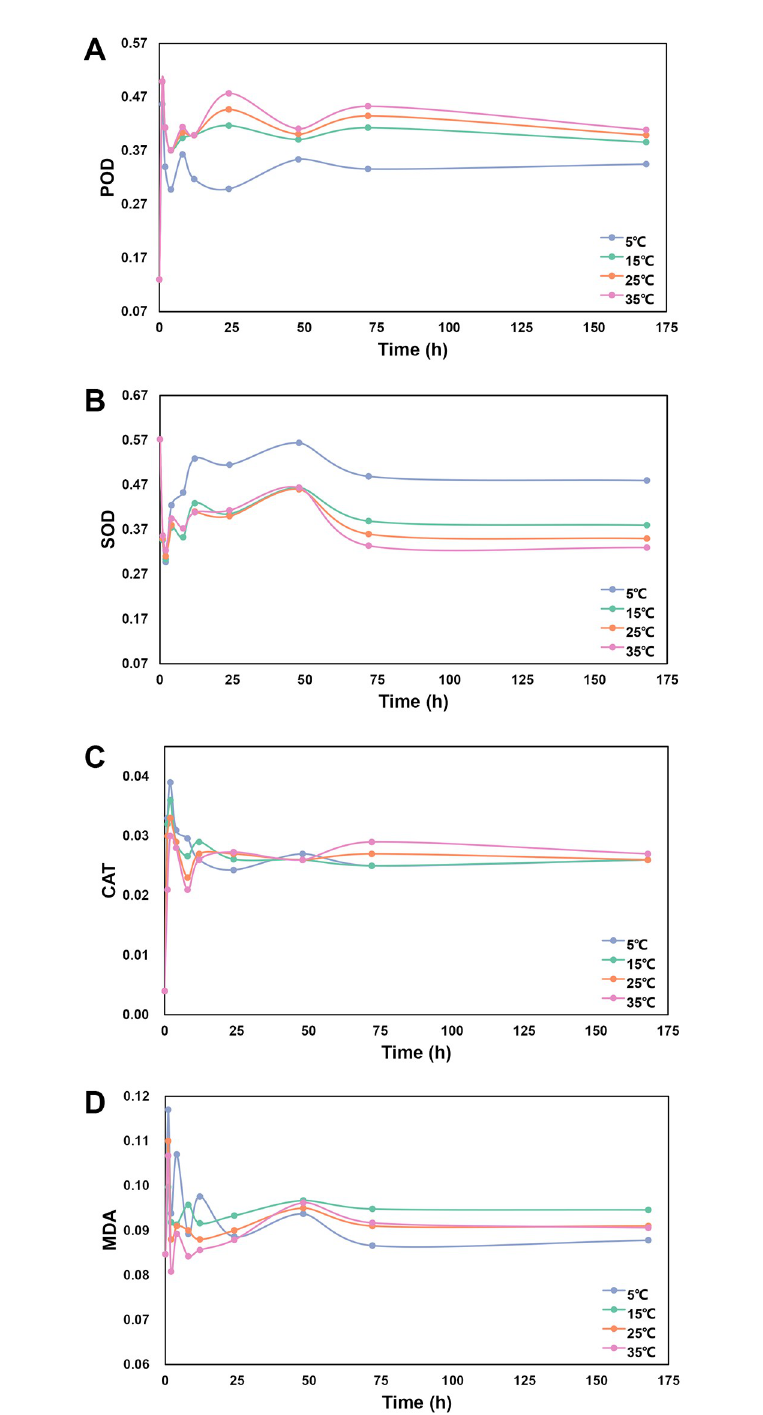
Fig 1. ROS detoxifying enzymes activity and MDA content. (A) Changes of POD activity during incubation time. (B) Changes of SOD activity during incubation time. (C) Changes of CAT activity during incubation time. (D) Changes of MDA content during incubation